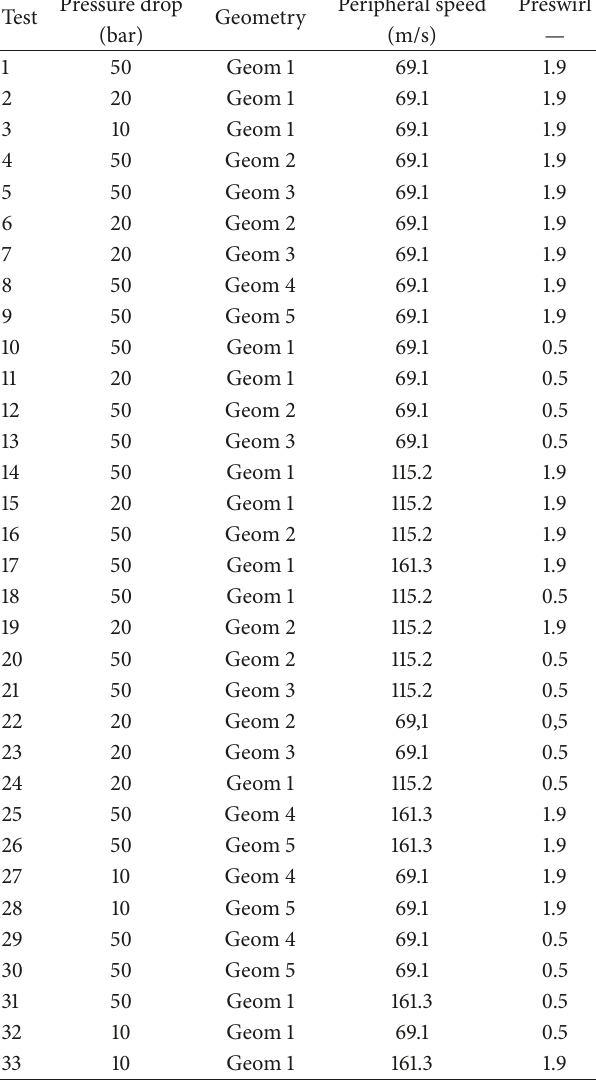
Table 2: Design of computer